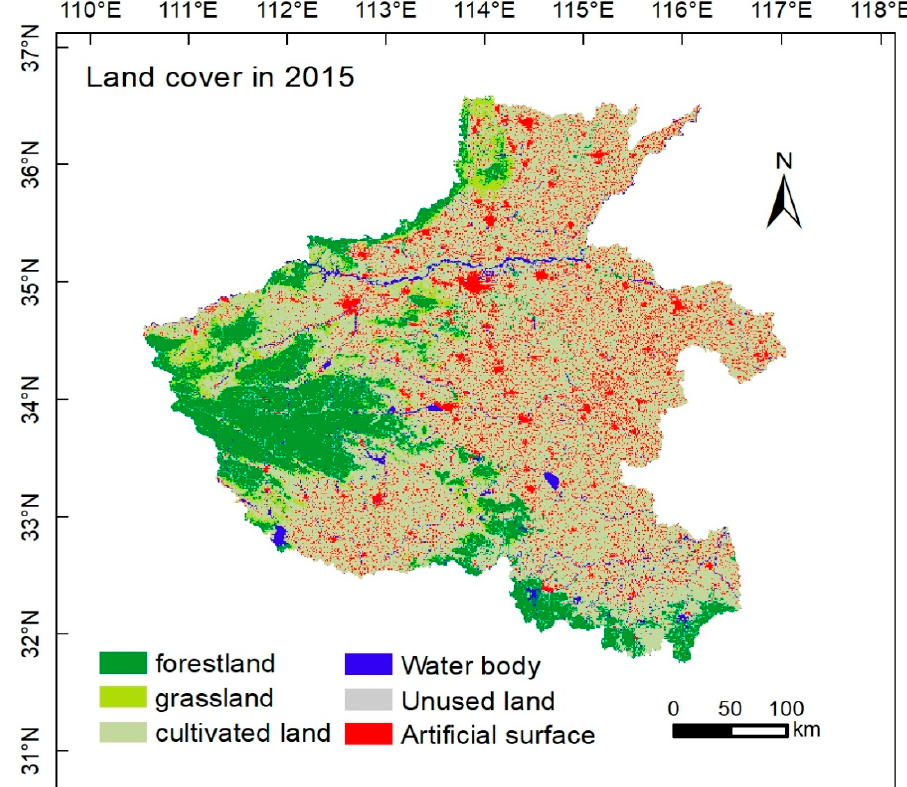
Figure 1. Remote sensing map of land cover in research